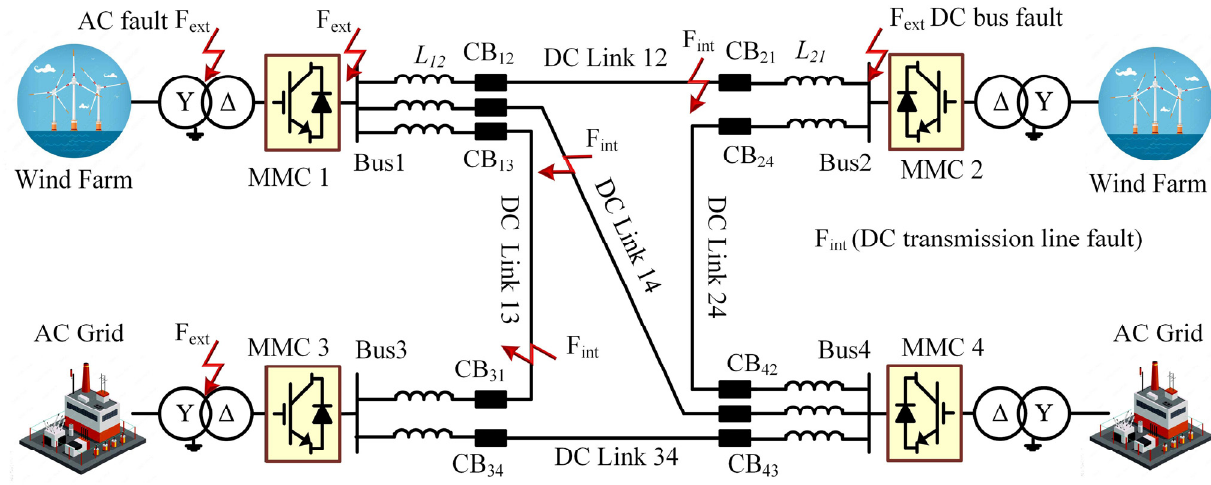
Figure 1. Proposed architecture.